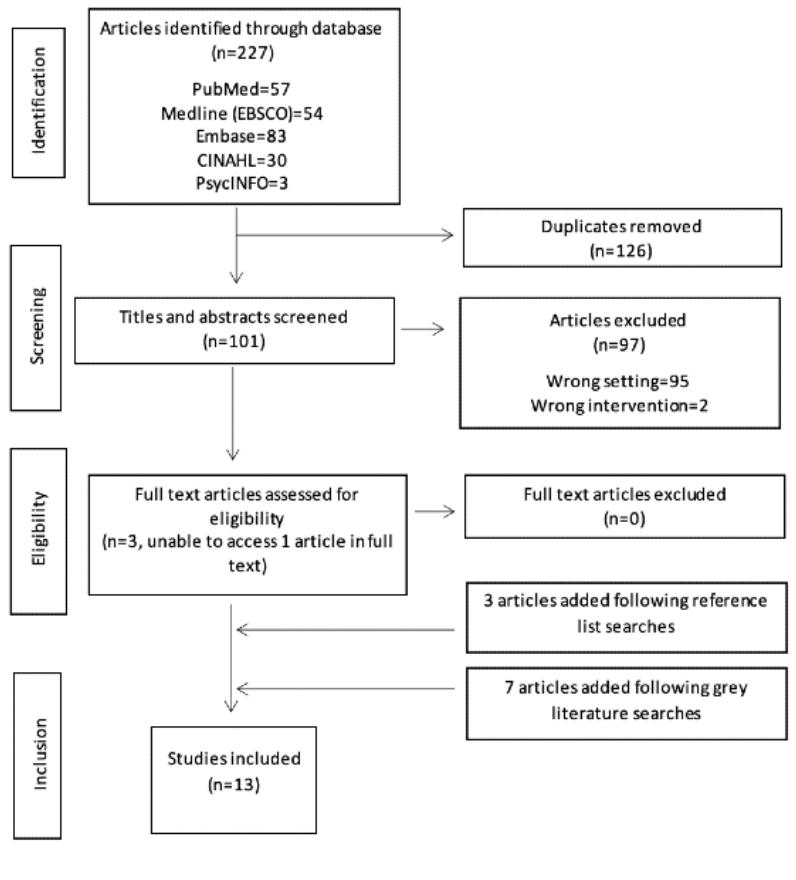
Figure 1. PRISMA diagram of included studies. PRISMA: Preferred Reporting Items for Systematic Reviews and